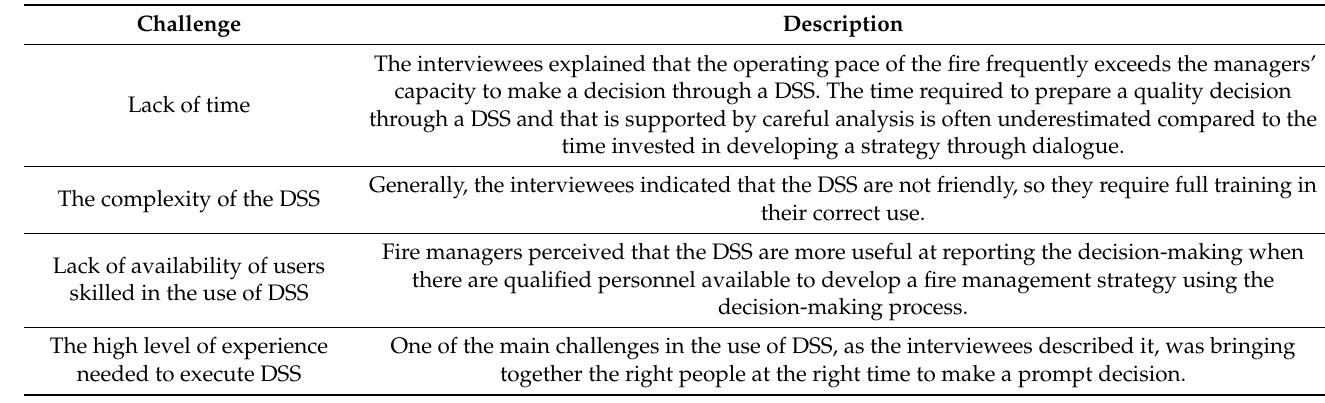
Table 1. Challenges for DSS in wildland fires in the USA according to Noble [33].